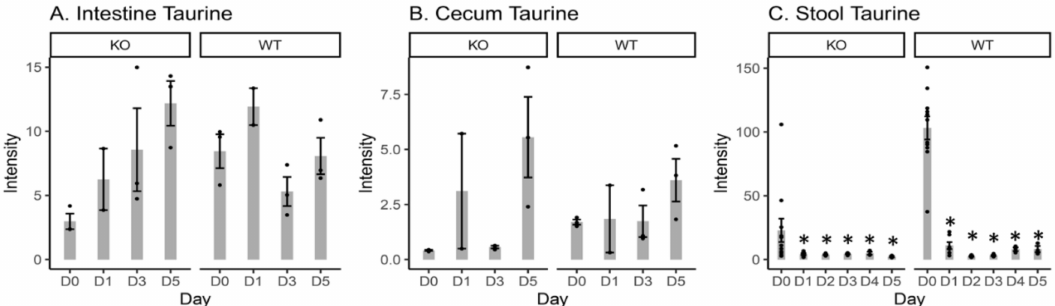
Figure 4. Bar plots of the intensity of free taurine in the intestinal content ( A ), cecal content ( B ), and stool samples ( C ) from both KO and WT mice. D0 = day 0 (prior to Cef treatment); D1, D2, D3, D4 and D5 = 1, 2, 3, 4, or 5 days after Cef treatment, respectively; * = significant changes at p < 0.05; • = intensity data from each individual